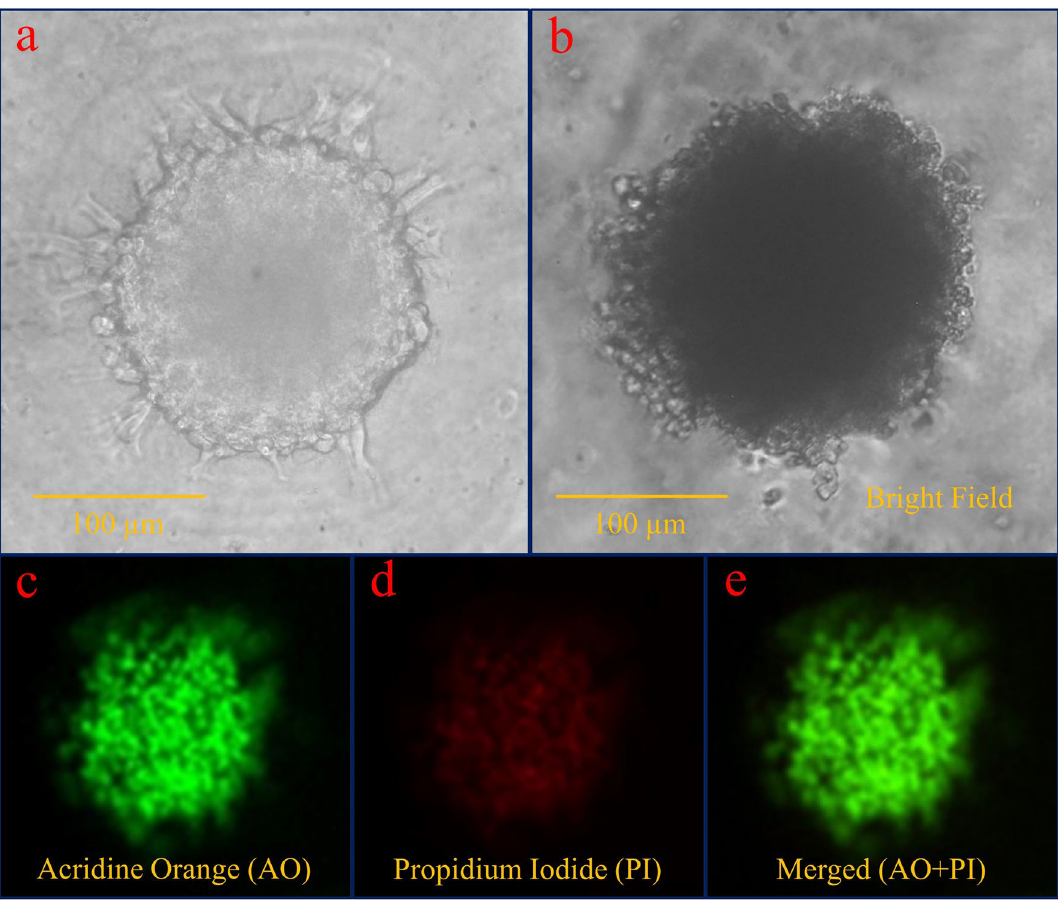
Figure 10. ( a ) The spheroid appears to have taken the shape of the container (hexagonal shape) during cell aggregation. ( b – e ) The result of the viability assay using AO/PI staining after 4 days of spheroid formed. Green color for merged image illustrates the high percentage of live cells versus dead